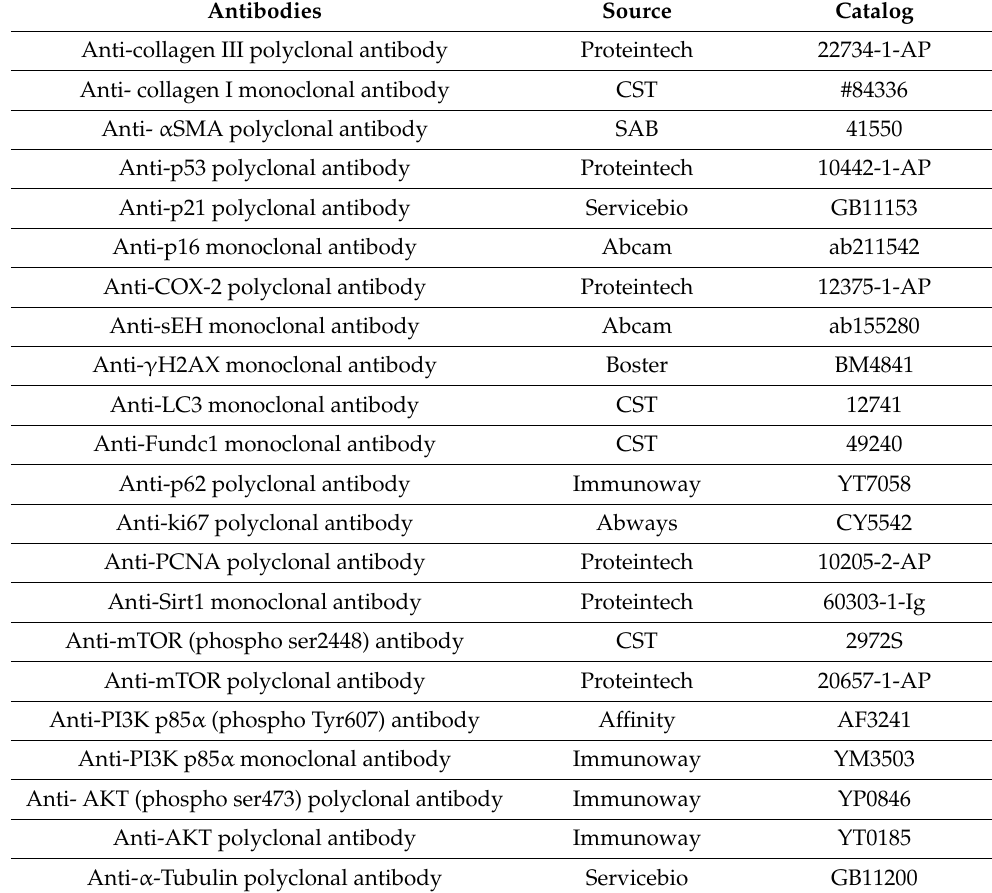
Table 1. Antibodies were used in this study.